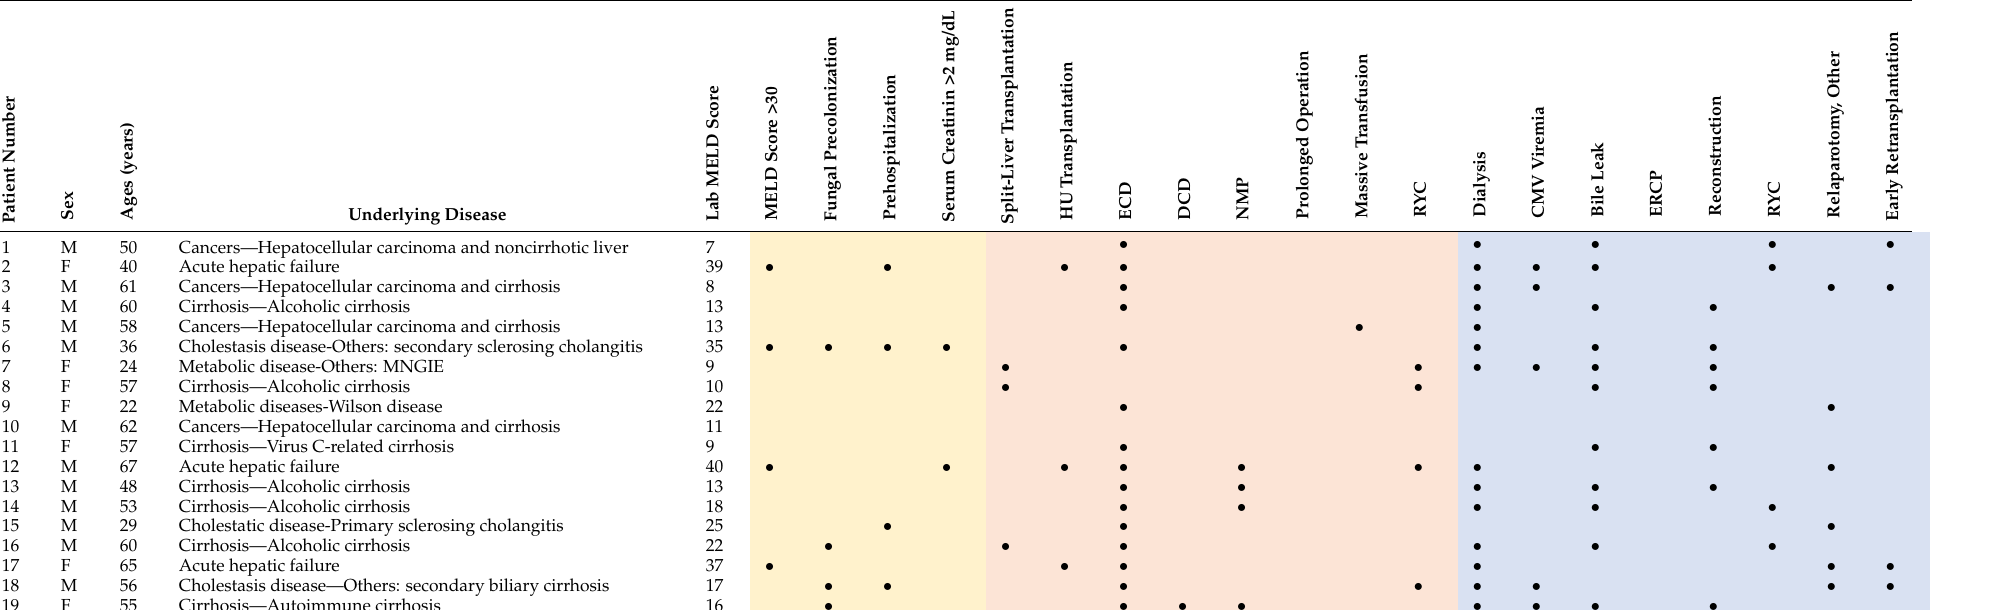
Table 2. Clinical characteristics and risk profile of patients with IFI ( n =